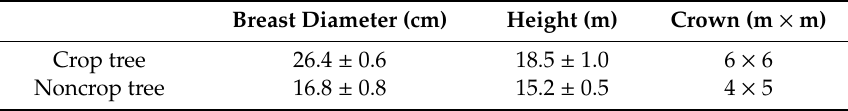
Table 1. Growth status indicators of crop trees and noncrop trees.